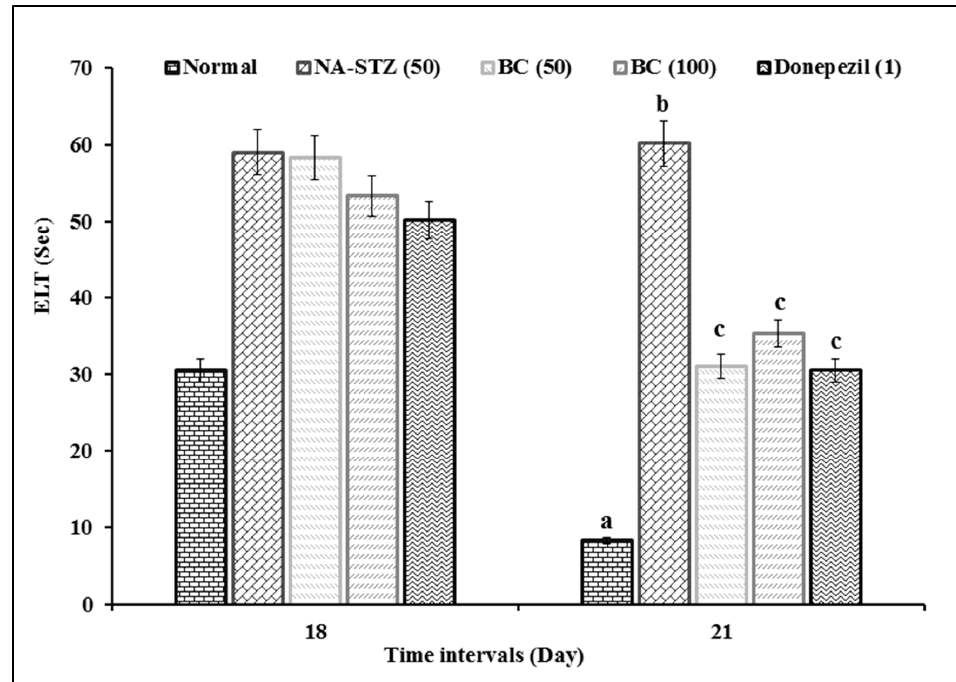
Figure 1. Effect of BC on ELT in MWM. Digits in parenthesis indicated dose in mg/kg. Data were expressed as mean ± SD; n = 12 rats. a p < 0.05 vs. ELT of normal group on day 18; b p < 0.05 vs. ELT of normal group on day 21; and c p < 0.05 vs. ELT of VaD group on day 21. Abbreviations: BC, beta-carotene; ELT, escape latency time; NA, nicotinamide; and STZ, streptozotocin.